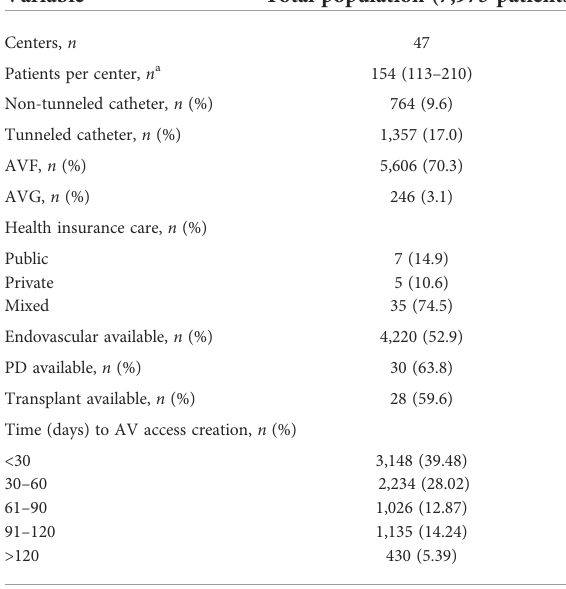
TABLE 2 Clinical and demographic characteristics of the study